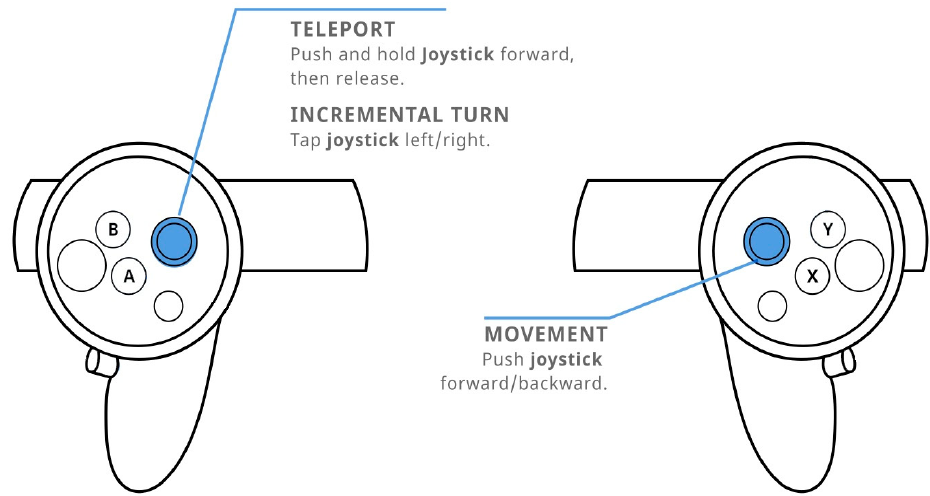
Figure 2. Oculus thumbstick navigation commands via teleport ( left ) and navigation via natural locomotion movement ( right ) [44].